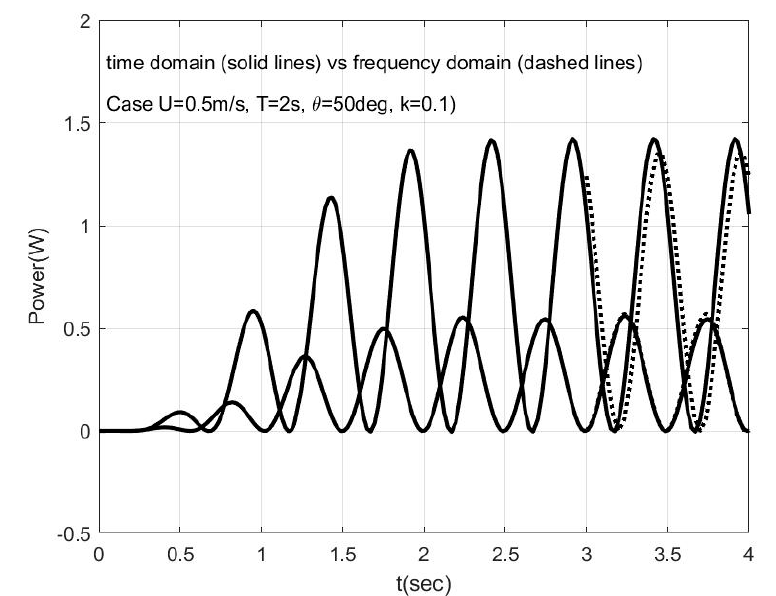
Figure 12. Calculated input and output power as a function time for the same conditions as in Figure 11. The results obtained by time-domain model are indicated by using solid lines and those by the frequency domain model by using dotted lines, respectively.